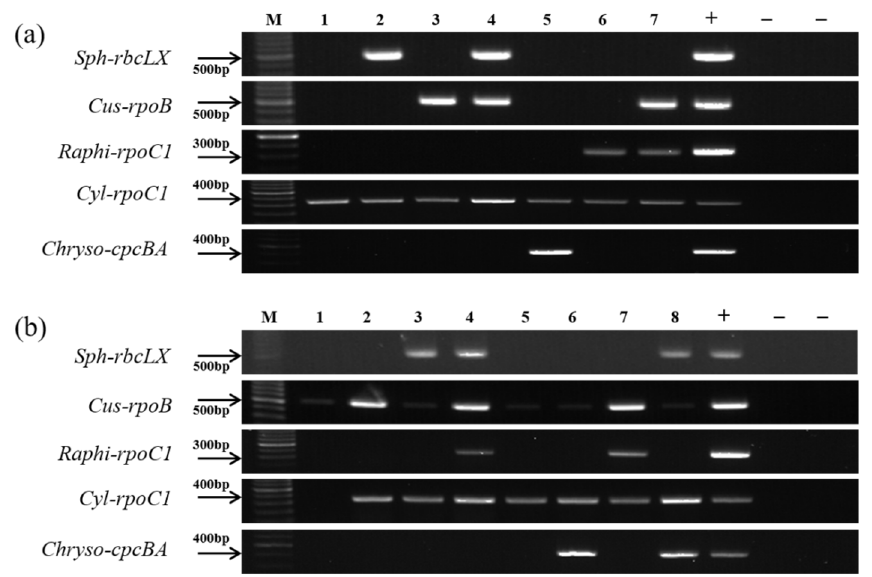
Figure 7. Agarose gel electrophoresis of PCR products obtained with genus-specific primers in ( a ) mixed samples of various cyanobacterial cultures (Table 1b) and ( b ) field samples mixed with cyanobacterial cultures (Table 1c). Positive (+) and negative ( − ) controls were used as described in the Materials and Methods. M: SiZer-100 DNA marker.